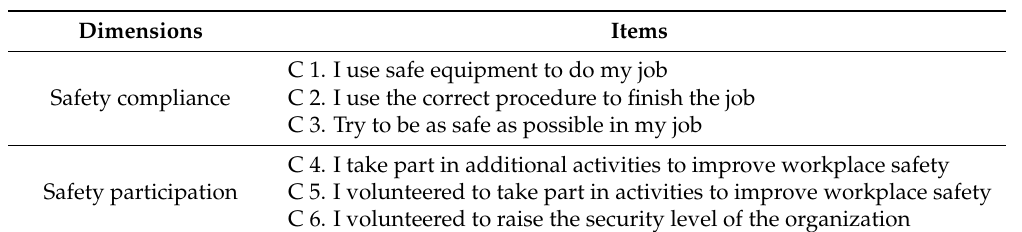
Table 2. Safety behavior